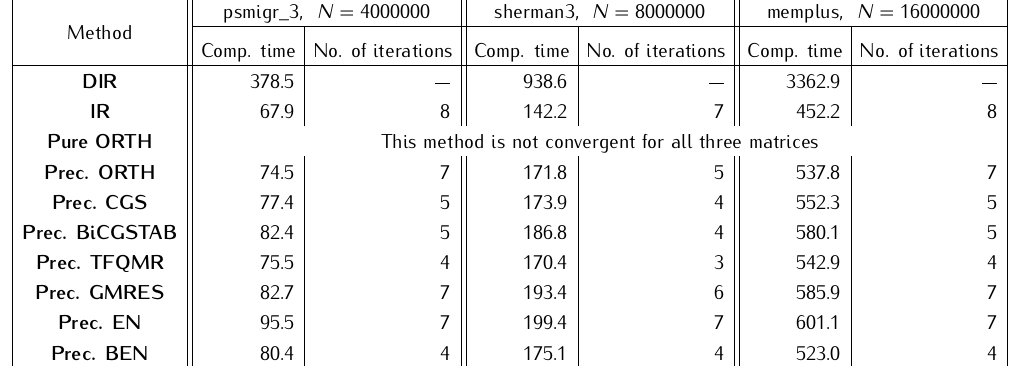
Table 19. Computing times obtained when three matrices produced by CLASSF are used. The right-hand side vector b is produced by using x q = 1 , q = 1 , 2 ,...,N , and when ACCUR = 10 − 10 . The relative drop-tolerance is RELTOL = 2 − 5